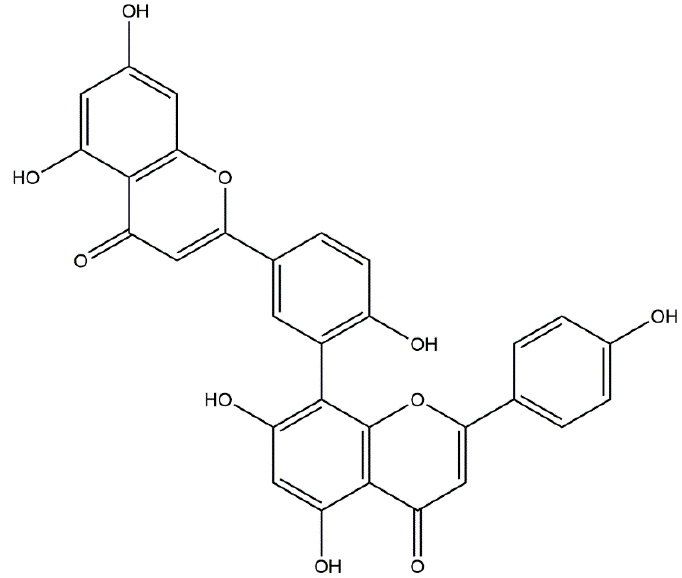
Figure 1. The structure of amentoflavone.